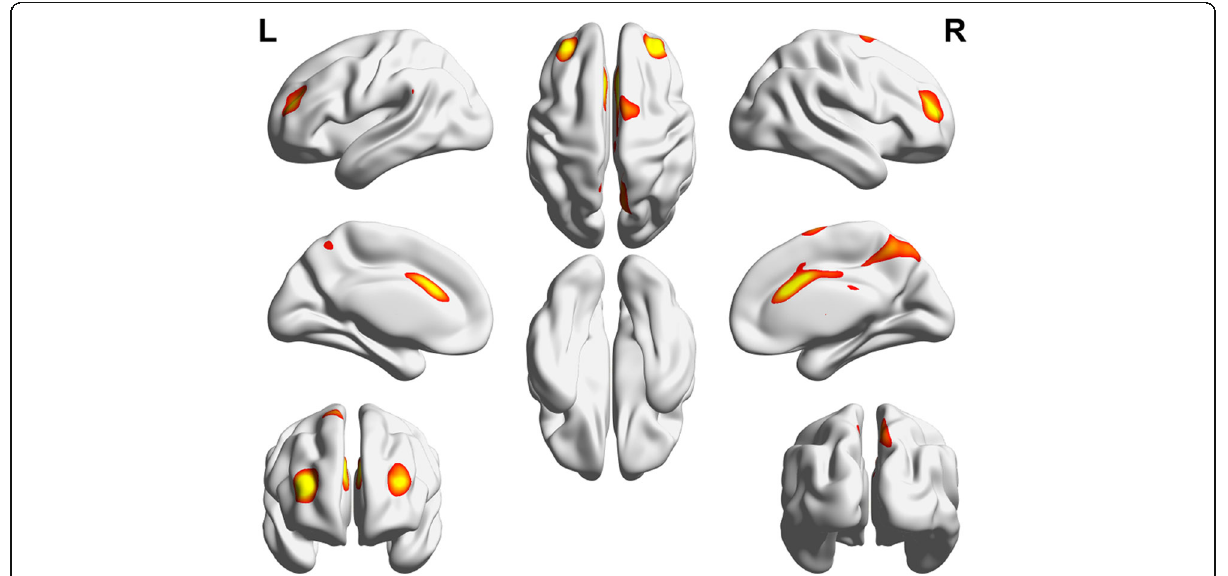
Fig. 3 Pain matrix. The functional network (IC 3) included the dorsolateral prefrontal cortex, anterior insular cortex, anterior cingulate cortex, thalamus, and precuneus, suggesting a pain